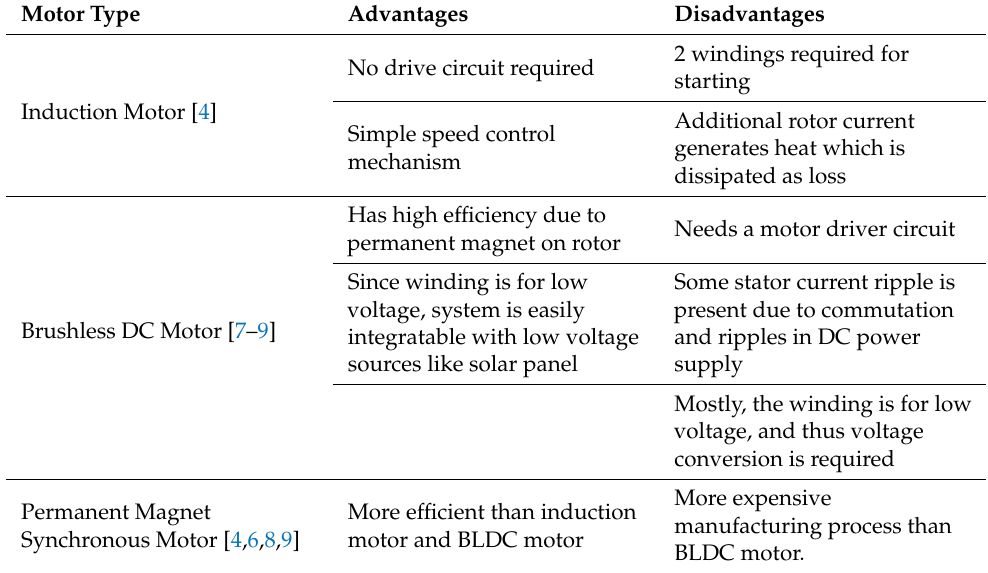
Table 1. Comparison of motor